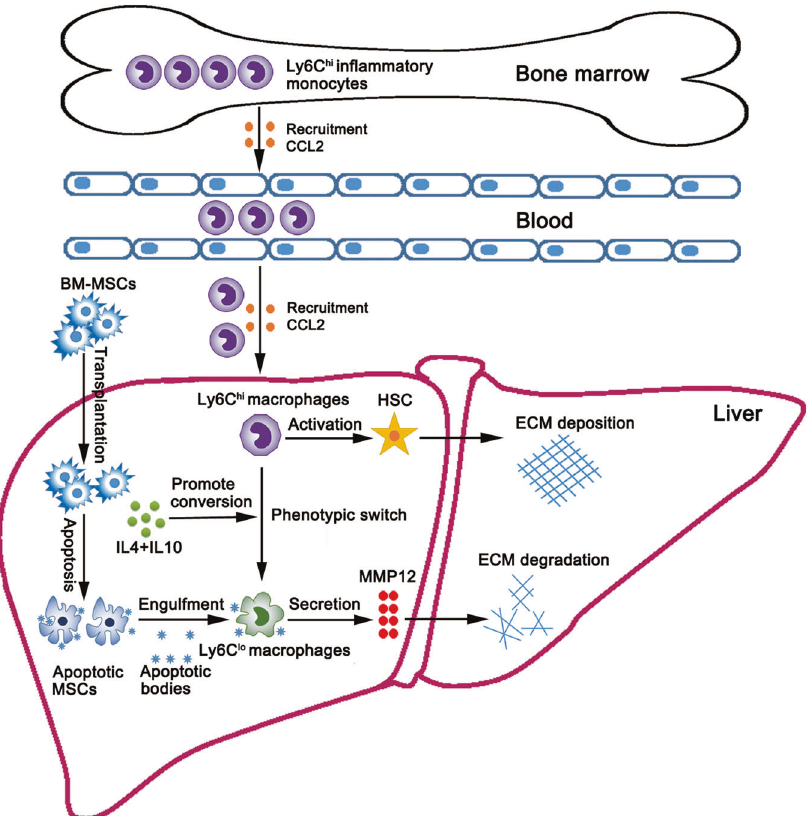
Fig. 8 Schematic of how BM-MSCs may decrease liver fi brosis by targeting Ly6C hi/lo macrophages through activating the cytokine- paracrine and apoptotic pathways. CCL2 secreted by the fi brotic liver promoted the recruitment of Ly6C hi monocytes from bone marrow to the liver. BM-MSC transplantation promoted the conversion of Ly6C hi to Ly6C lo macrophages by secreting cytokines IL4 and IL10, which decreased the activation of HSCs. Meanwhile, BM-MSCs experienced severe apoptosis and produced substantial apoptotic bodies, which were engulfed by Ly6C lo macrophages, leading to MMP12 release and accelerated extracellular matrix (ECM) degradation in CCL4-induced liver fi